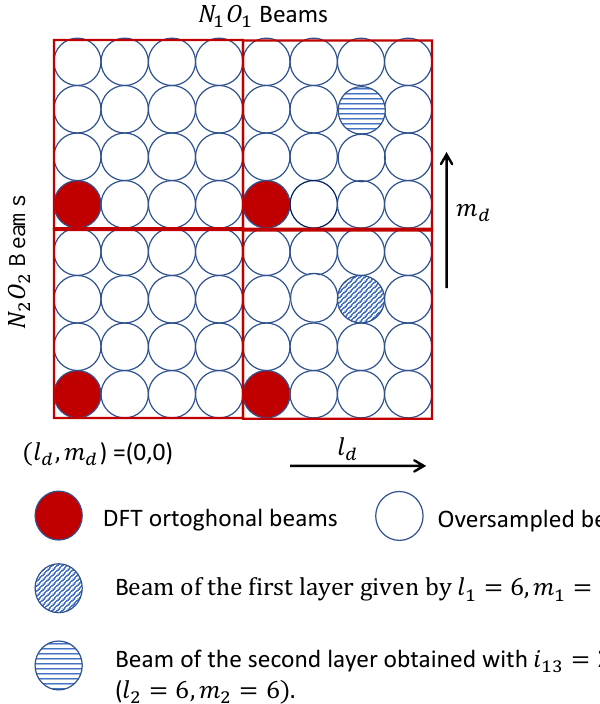
Figure 3. Grid of beams of a single-panel UPA with 𝑁 1 = 2, 𝑁 2 = 2, and 𝑂 1 = 𝑂 2 = 4. It is assumed that 𝑁 𝑠 = 2, 𝑖 11 = 6, 𝑖 12 = 2, and 𝑖 13 =